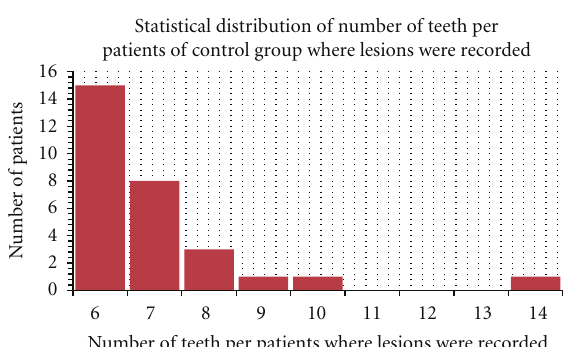
Figure 3: Number of caries recorded in control group.